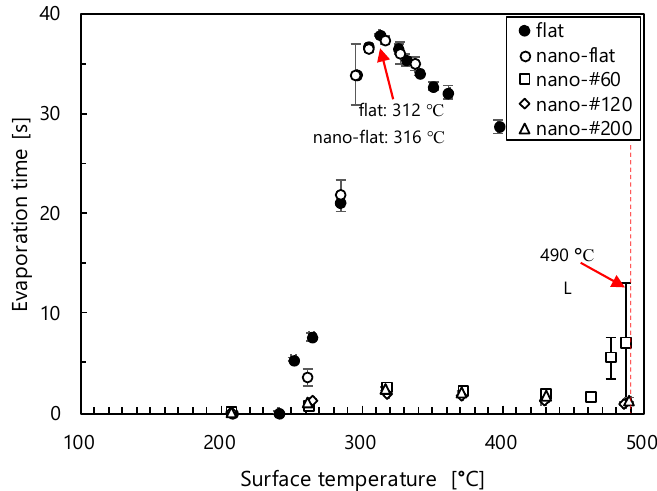
Figure 7. Evaporation time as a function of surface temperature on flat and nanocoated mesh surfaces.